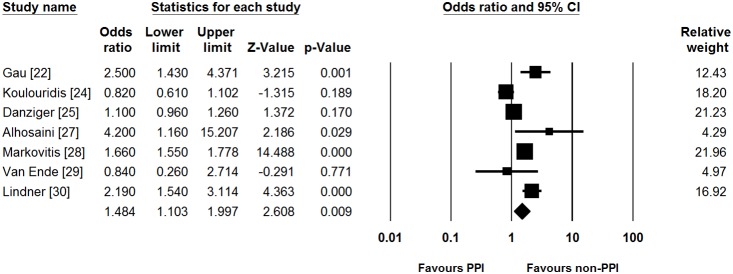
Forest plots for risk of hypomagnesemia.PPI, proton pump inhibitor; CI, confidence interval.